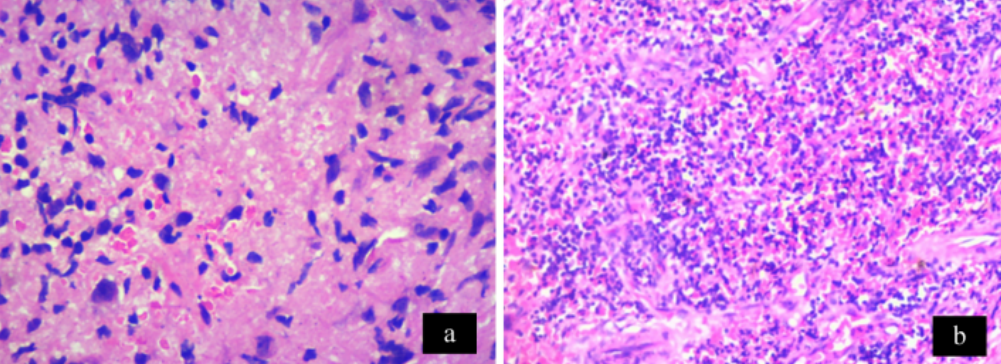
Figure 3: a) Histopathology of scleral scraping at presentation, and b) scleral biopsy at 1 week showing no organism with necrosis